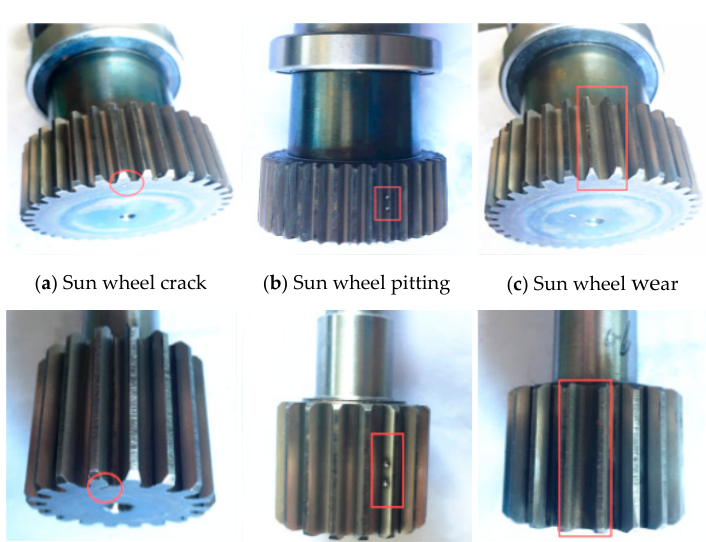
Table 3. The basic parameters of deep groove ball bearings.